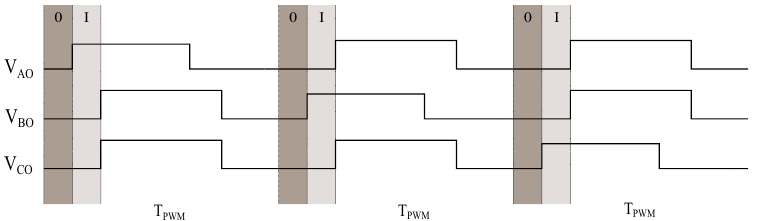
Figure 8. PWM excitation used for the measurement of the voltage v NV , where T PWM is the PWM period